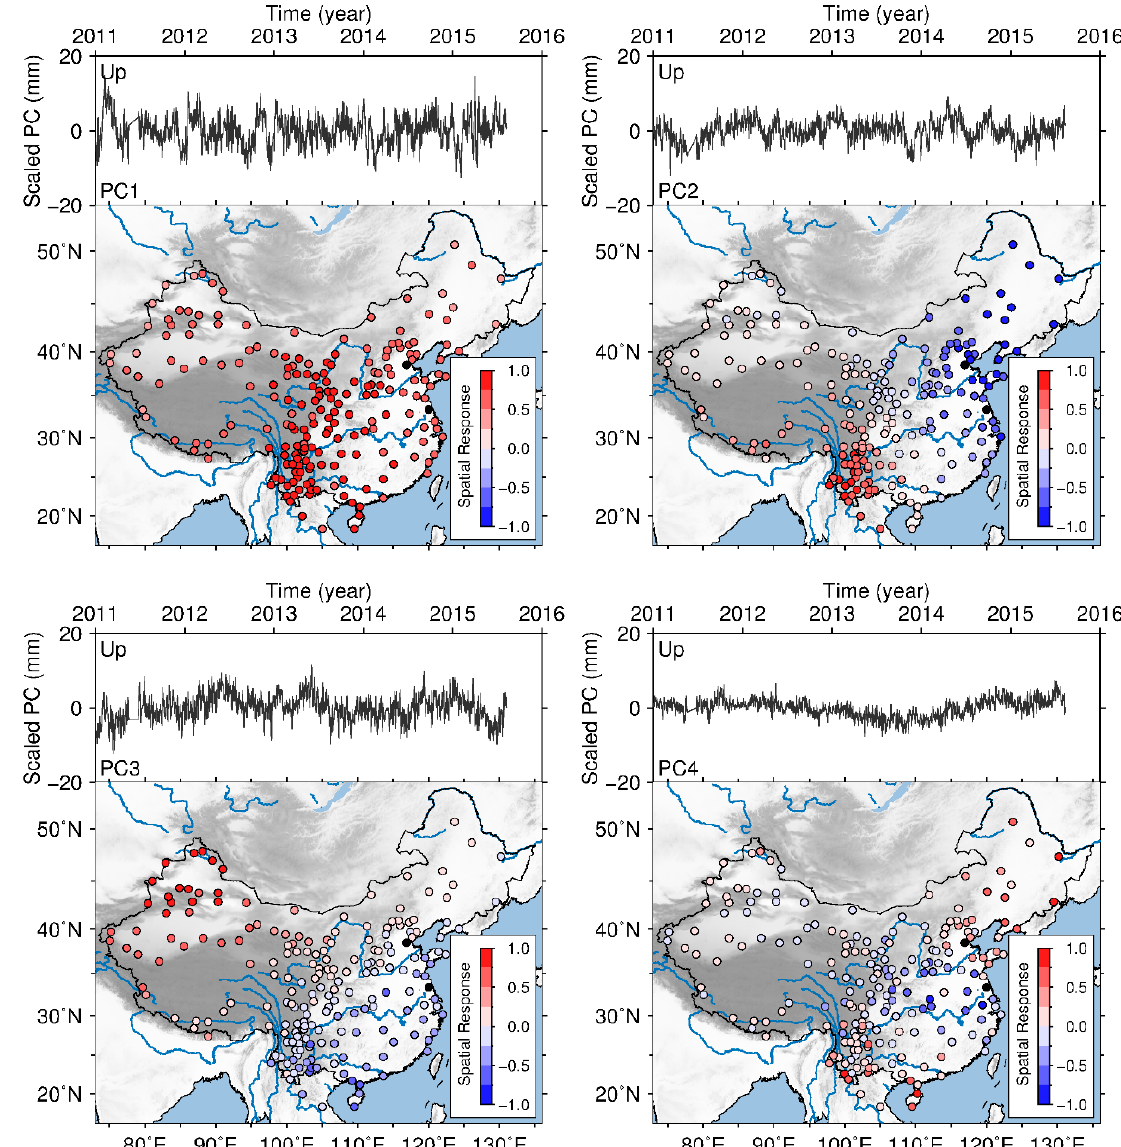
Figure 4. Temporal and spatial responses of the first four PCs for the up component of the CMONOC-II. Black dots indicate the excluded stations.